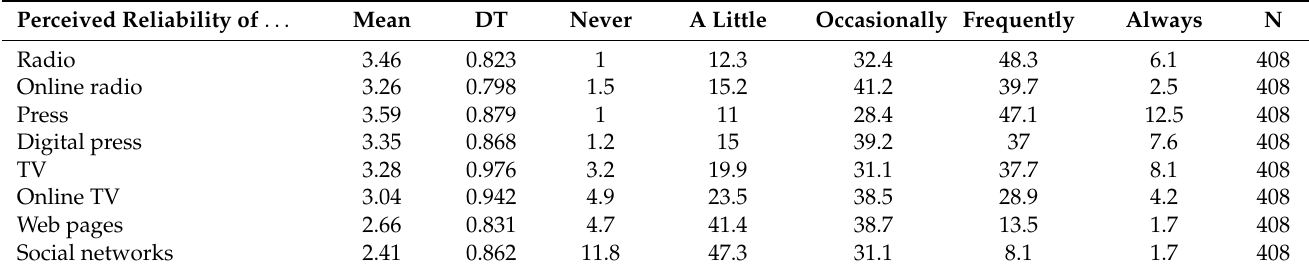
Table 3. Basic statistics for reliability perception in media consumed by Generation Z. Own elaboration. Perceived Reliability of . . .